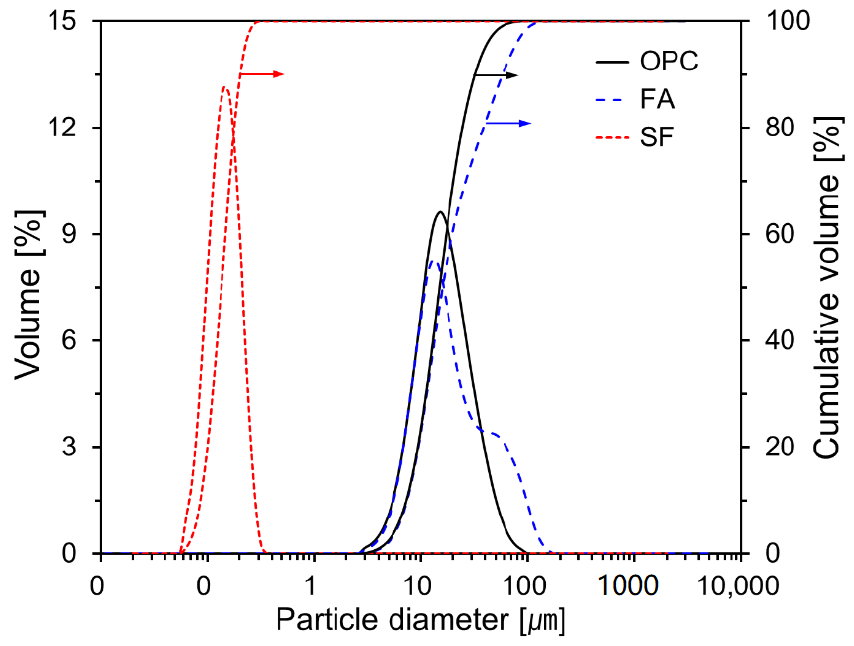
Figure 2. Particle size distributions for OPC, FA, and SF.